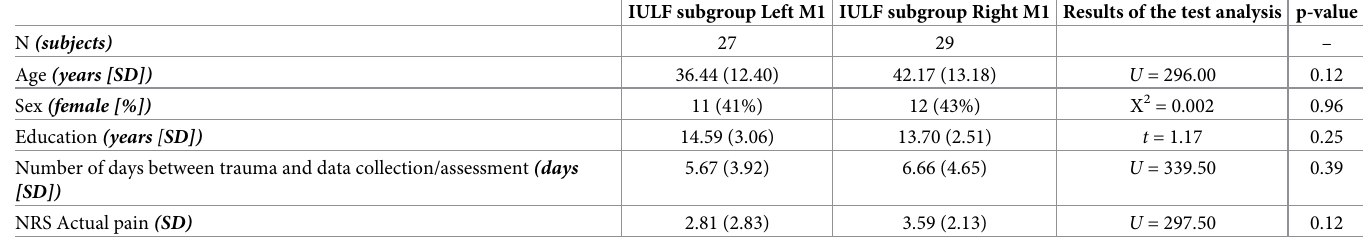
Table 3. Descriptive characteristics of IULF patients according to the stimulated